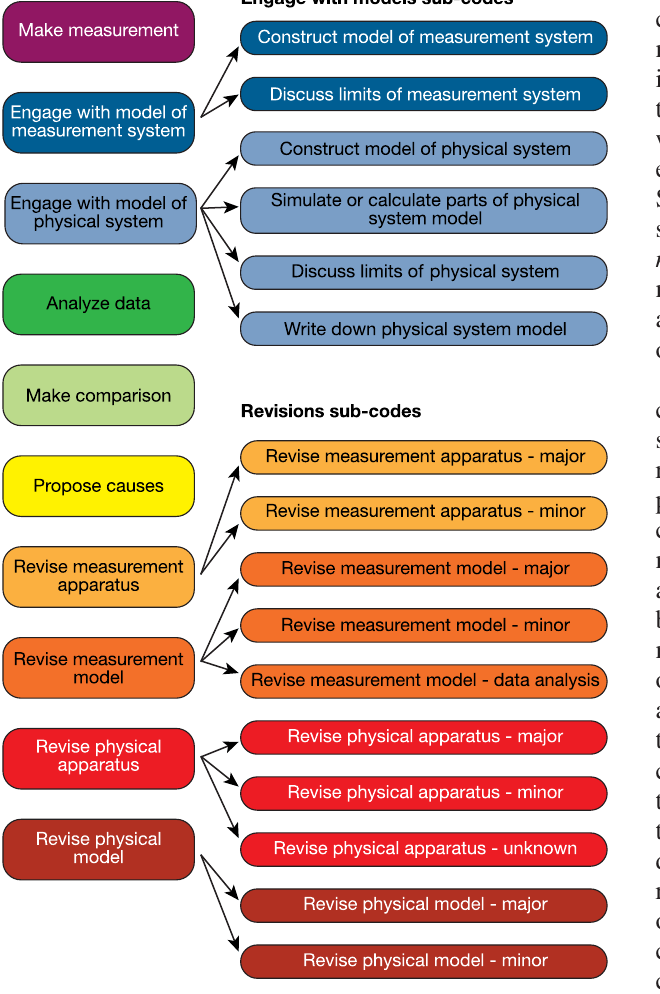
FIG. 2. Modeling codes. The main modeling codes coming directly from the EMF appear on the left, and the arrows point to subcodes for the engage with models and revisions